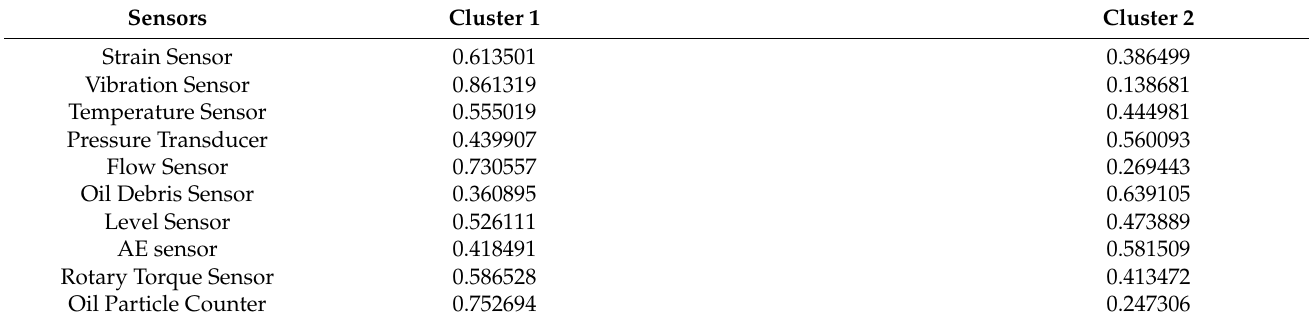
Table 8. The membership value of each sensor for the cluster with minimum value of J m